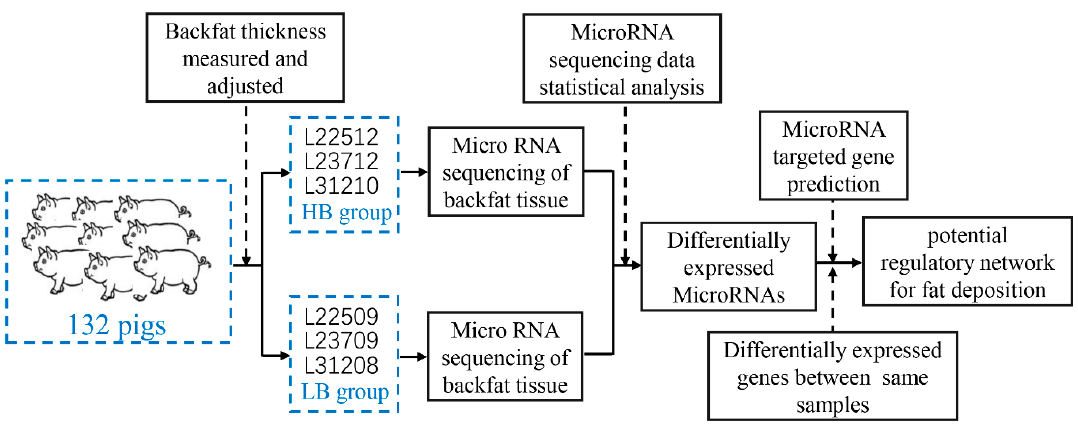
Figure 1. Experimental design used in this study. A total of 132 female Landrace pigs were separated into two groups. The HB group comprised pigs with high backfat thickness and included individuals L22512, L23712, and L31210. The LB group comprised pigs with low backfat thickness and included individuals L22509, L23709, and L31208. These six individuals were in the three HB/LB pairs of full-sibling pigs that showed extremes of backfat thickness and were selected for microRNA sequencing.